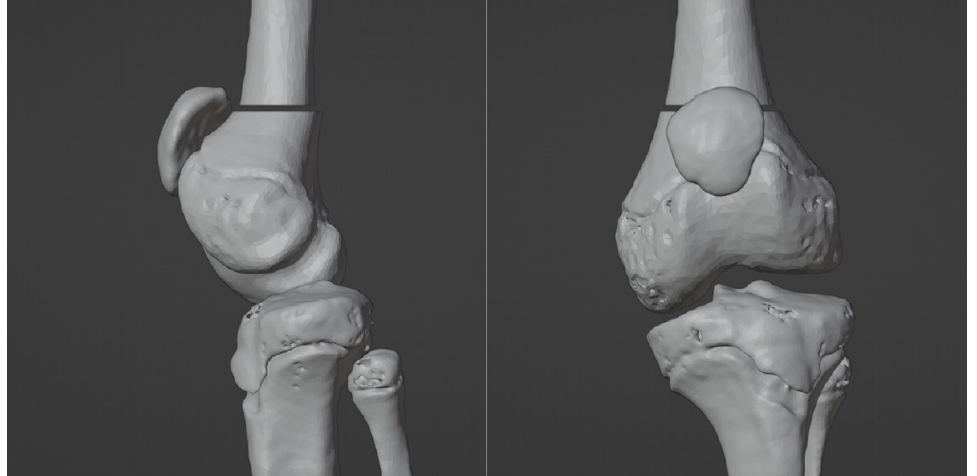
Figure 10. Femoral extension simulation.